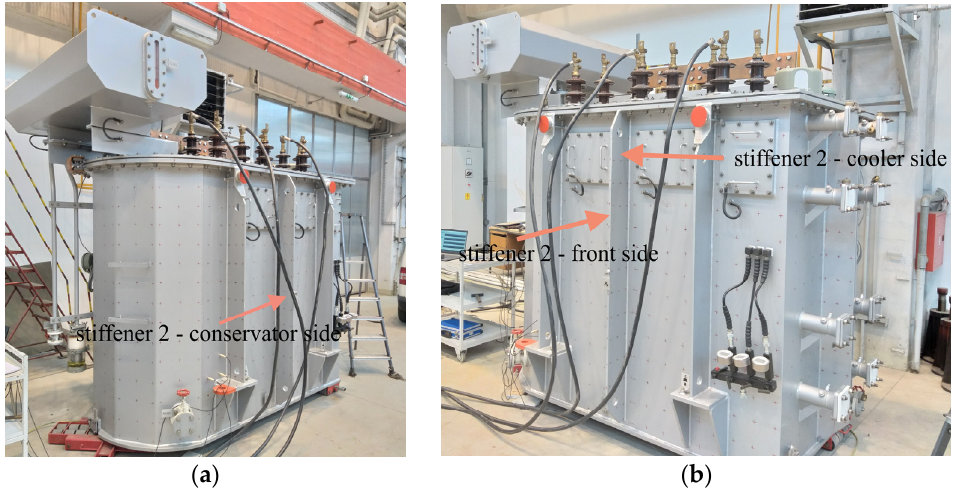
Figure 13. Stiffener 2 of transformer experimental model on which vibrations are measured with a view to (a) the conservator side (b) the front side and the cooler side